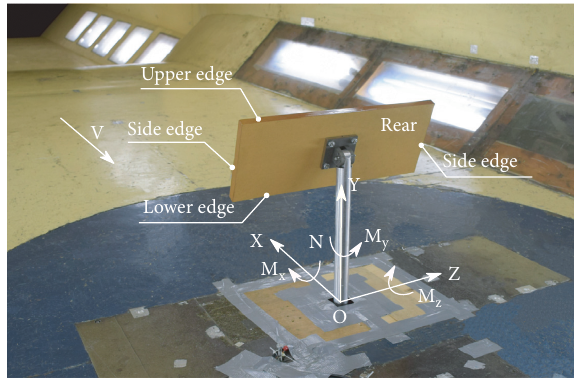
Figure 4: Reference system of strain balance (wind axis